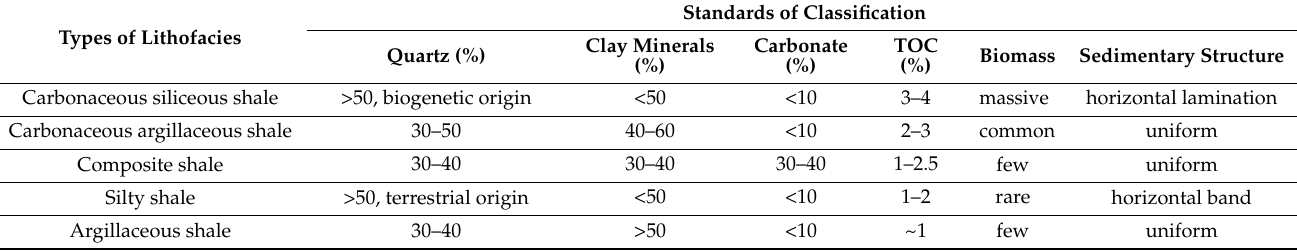
Table 4. Classification standards of sedimentary microfacies.